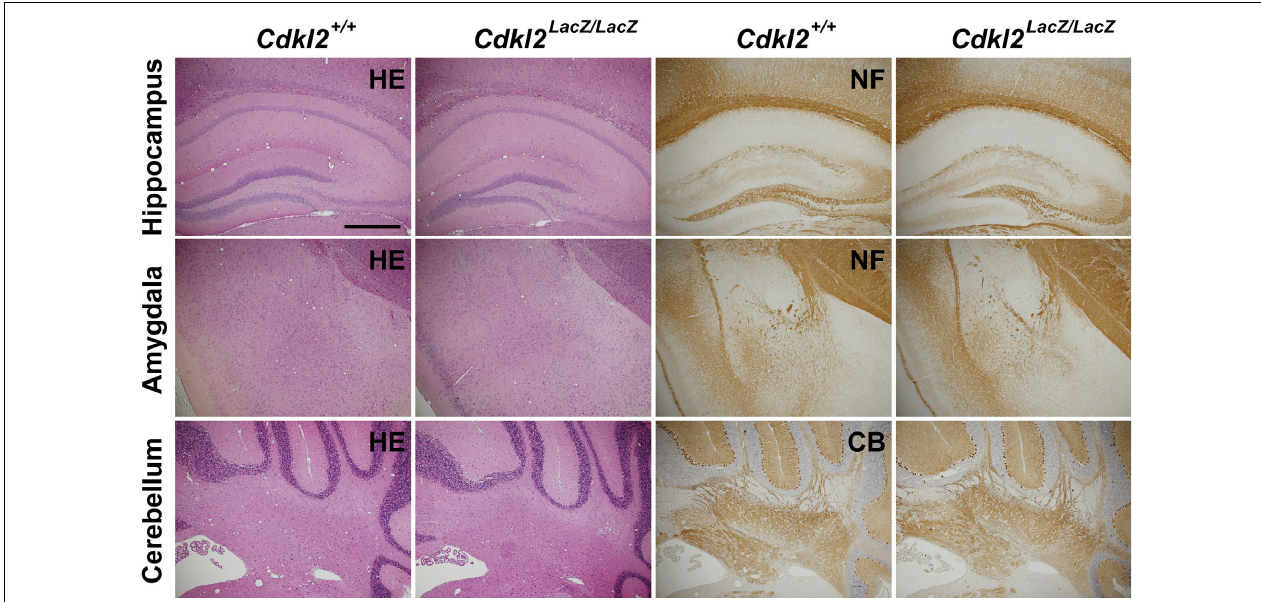
FIGURE 2 | Morphologic analysis. H-E-staining (HE) and immunohistochemistry for neurofi lament (NF) and calbindin-D (CB) in coronal brain sections of Cdkl2 + / + and Cdkl2 LacZ/LacZ mice. Scale bar: 500